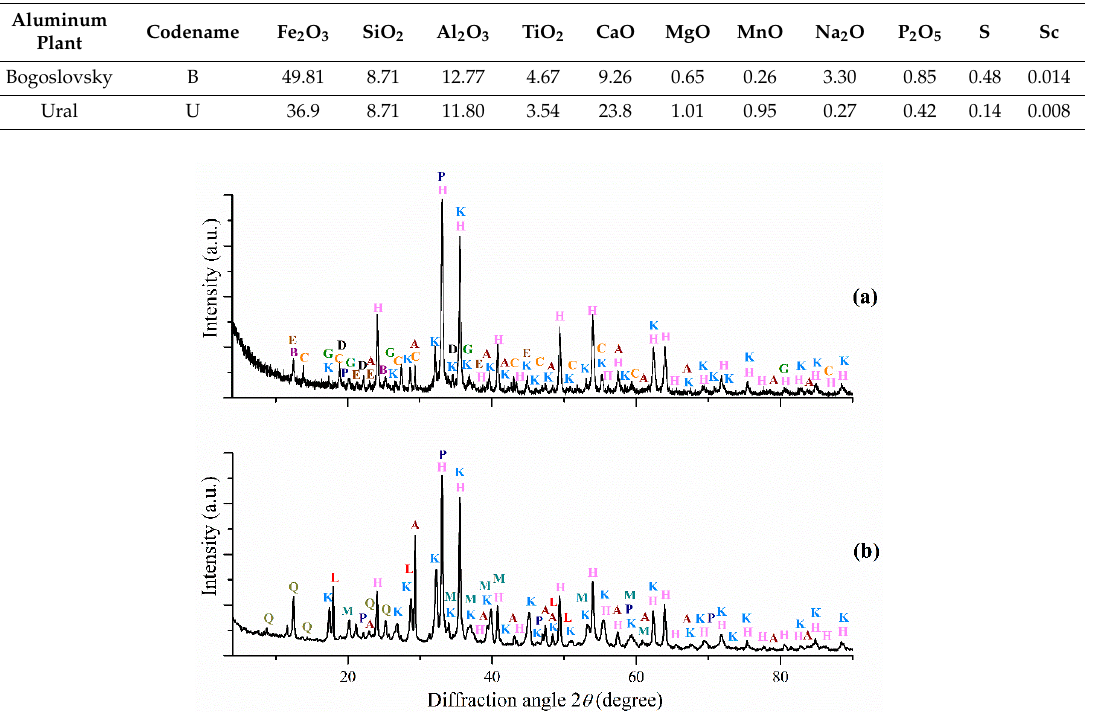
Table 1. Chemical composition of the red mud samples (wt.%).